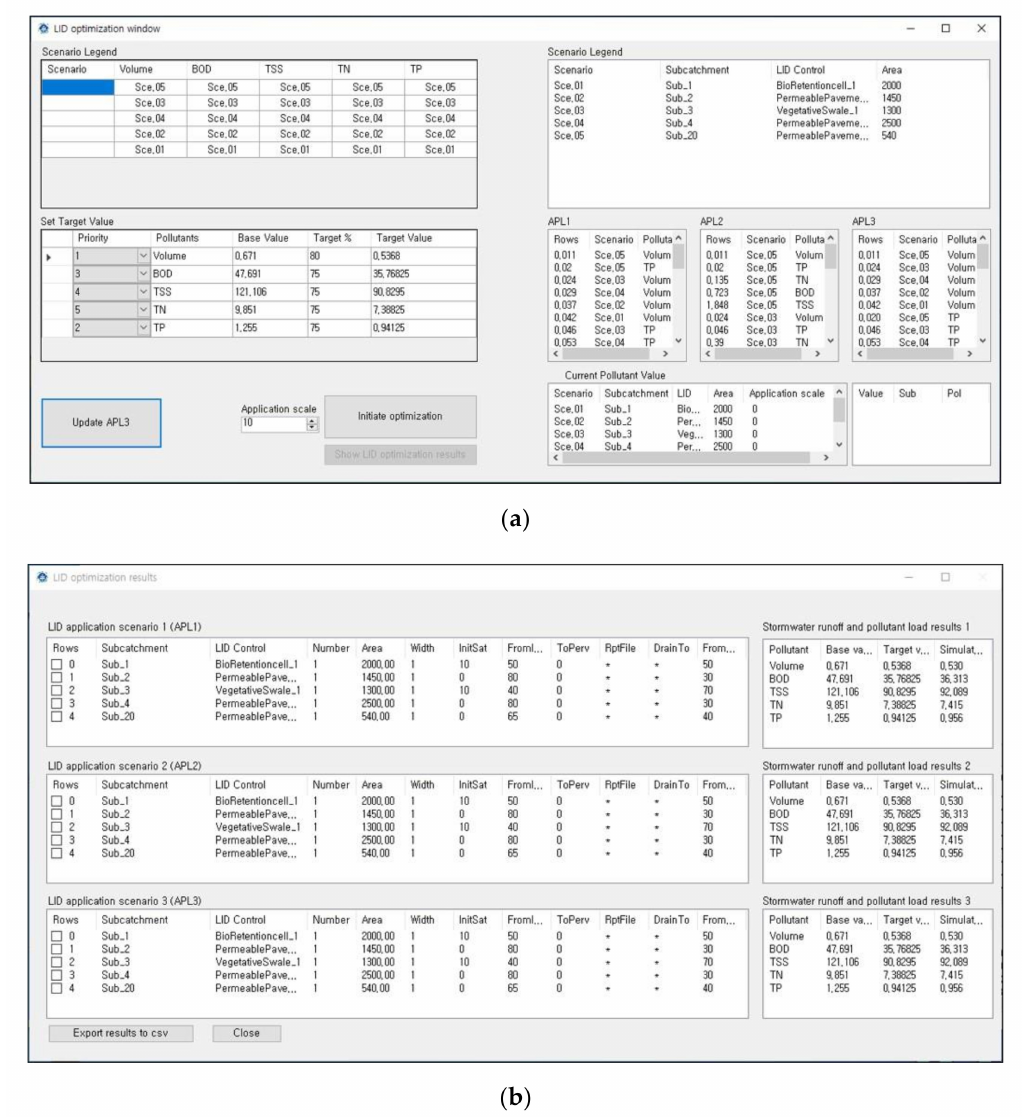
Figure 8. Storm Water Management Model–low impact development design program (SWMM-ING) interfaces to display LID optimization: ( a ) LID optimization window; ( b ) LID optimization results